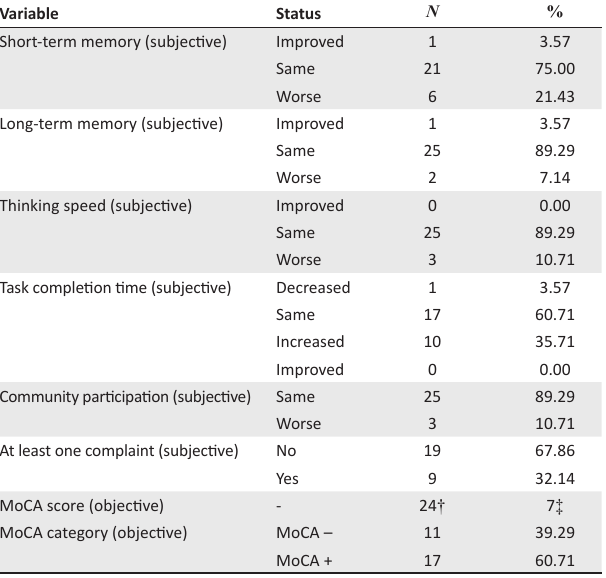
TABLE 2: Subjective and objective cognition status post-surgery ( N = 28).